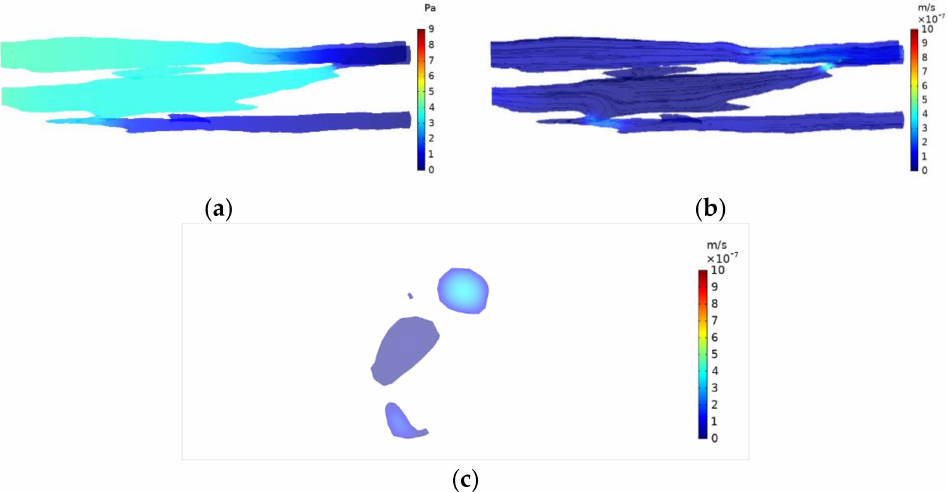
Figure 15. Distributions of pressure field and velocity field with pressure difference of 4 Pa. ( a ) Distribution of pressure field; ( b ) distribution of velocity field; ( c ) velocity profile in the middle part of